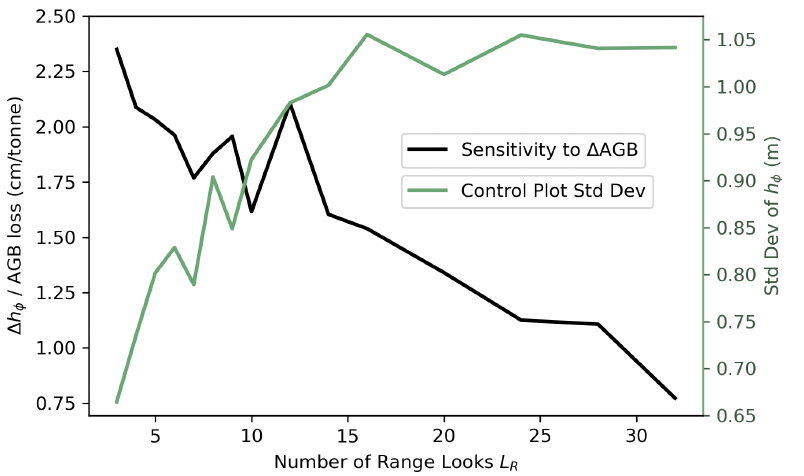
Figure 6. (black, left hand y-axis) Modeled drop in phase height ( h φ ) in cm per Mg of AGB loss, calculated for various levels of multilooking. (green, right hand y-axis) Standard deviation of ∆ h φ for the 11 control plots, plotted against multilooking level.